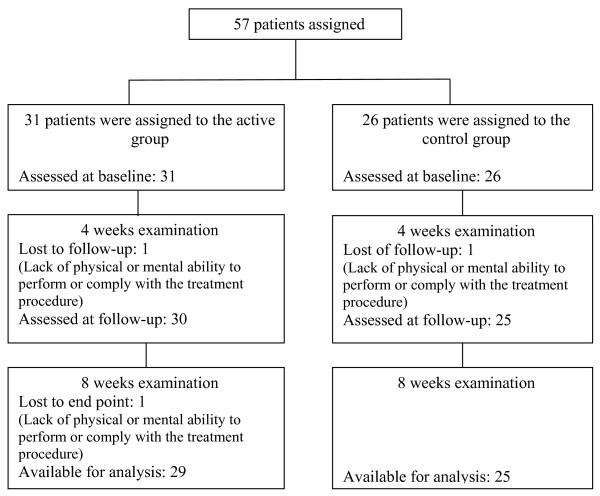
Patient flow-chart.